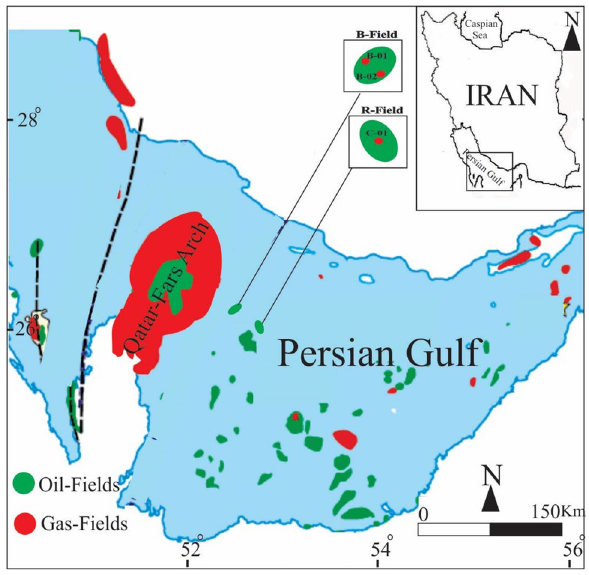
Fig. 1 Location map of studied fields in the central Persian